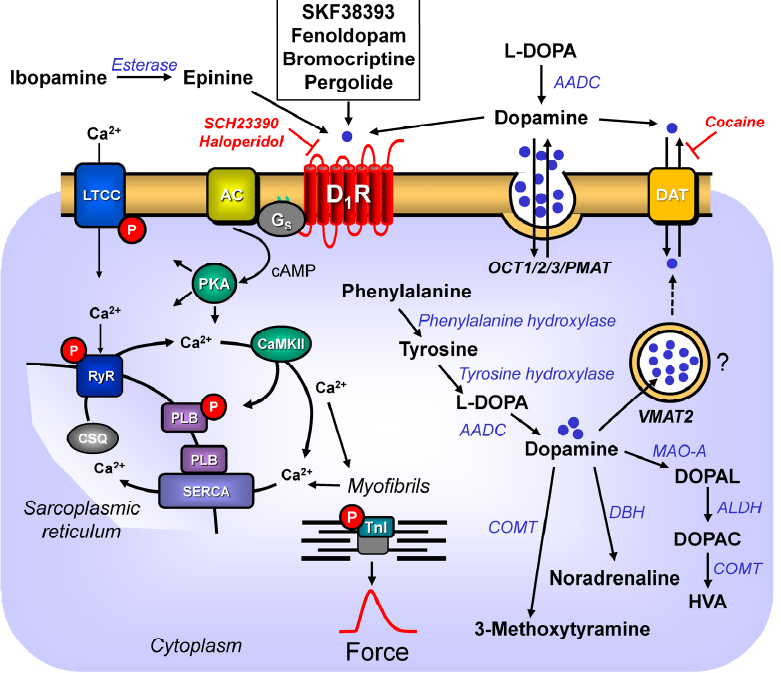
Figure 1. Dopamine might stimulate D 1 -dopamine receptors in the sarcolemma. This would activate the stimulatory GTP-binding protein (Gs), and thereby, the activity of adenylyl cyclases (AC) would be enhanced. AC will catalyze the conversion of ATP to cAMP. This cAMP can activate cAMP-dependent protein kinases (PKA), leading to an increase in the phosphorylation states of regulatory proteins. For instance, phosphorylation of L-type Ca 2+ channels (LTCC) will lead to more of an influx of Ca 2+ from the extracellular space. This Ca 2+ will facilitate the release of Ca 2+ through the phosphorylated ryanodine receptor (RYR) into the cytosol. The cytosolic Ca 2+ activates a Ca 2+ calmodulin-dependent protein kinase (CaMKII) that can phosphorylate phospholamban (PLB), the inhibitory protein of the sarcoplasmic reticulum Ca 2+ ATPase (SERCA). Possibly, dopamine can also be synthesized in cardiomyocytes. Phenylalanine is oxidized by phenylalanine hydroxylase to tyrosine. Tyrosine is in due course oxidized by tyrosine hydroxylase to L-DOPA, and aromatic L- amino acid decarboxylase (AADC) forms dopamine. Dopamine can be oxidized by dopamine- β - hydroxylase (DBH) to noradrenaline. Catechol- O -methyl transferase (COMT) forms 3- methoxytyramine. Monoamine oxidase A (MAO-A) will oxidize dopamine to dihydroxyphenylacetaldehyde (DOPAL) and aldehyde dehydrogenase (ALDH) to dihydroxyphenylacetic acid (DOPAC), and finally, COMT will form homovanillic acid (HVA). Dopamine, at least in nerve cells, can be transported by a vesicular monoamine transporter (VMAT2) into vesicles. These vesicles can release dopamine to the extracellular space. Dopamine can enter the cell via a dopamine transporter (DAT) or via other transporters (OCT, organic cation transporter; PMAT, plasma membrane monoamine transporter). Additionally, the D 1 -dopamine receptor can also be stimulated (see Table 1A) by fenoldopam, SKF38393, bromocriptine, pergolide, and possibly epinine. Epinine is formed from ibopamine through the activity of esterases. The D 1 - dopamine receptor will be blocked by haloperidol, but also by SCH23390 (see Table 1B).